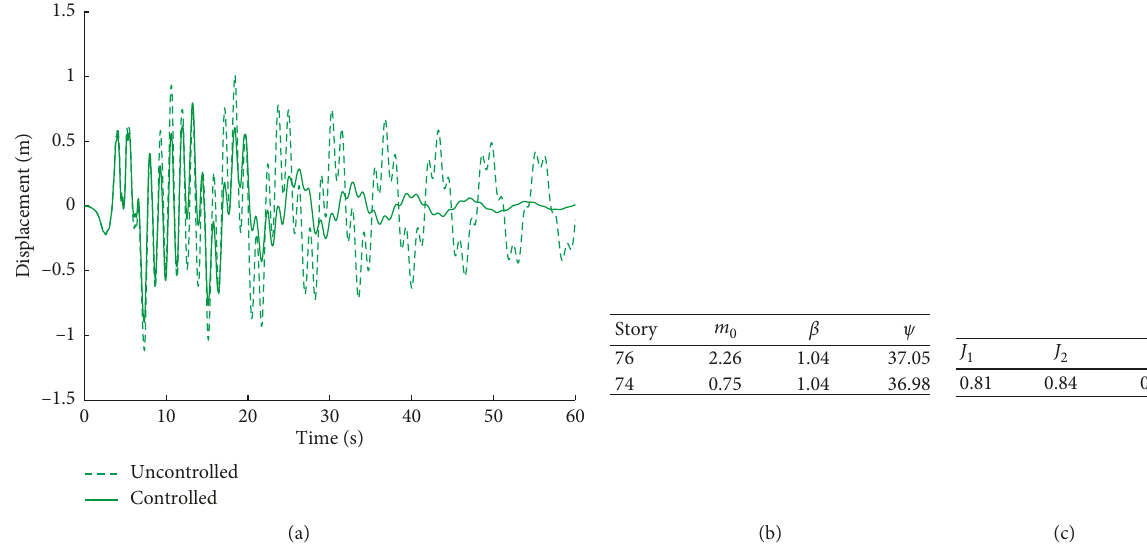
Figure 16: Uncontrolled/controlled responses under the Northridge earthquake. (a) Roof displacement response. (b) TMD specifications. (c) Objective values.